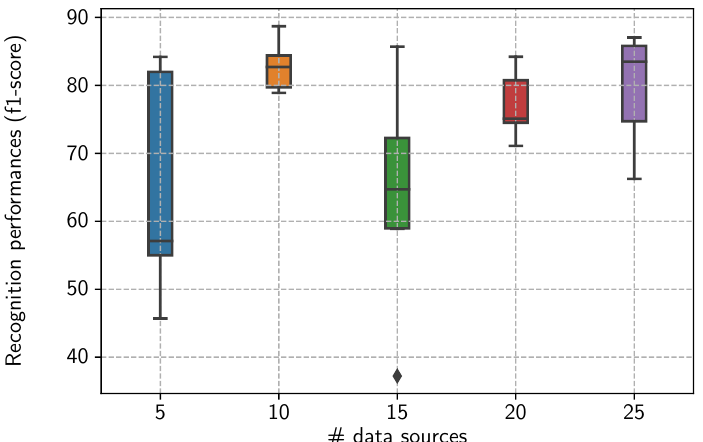
Figure 22. Recognition performances, measured by the f1-score, as a function of the number of data sources (the cardinality on average of the subsets ) used to train the deployed activity recognition |S y | models. The configuration with 25 data sources corresponds to subsets where all data sources are used, i.e., no privileged information